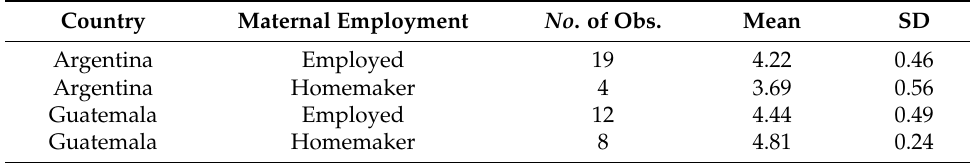
Table 4. Country and maternal employment.